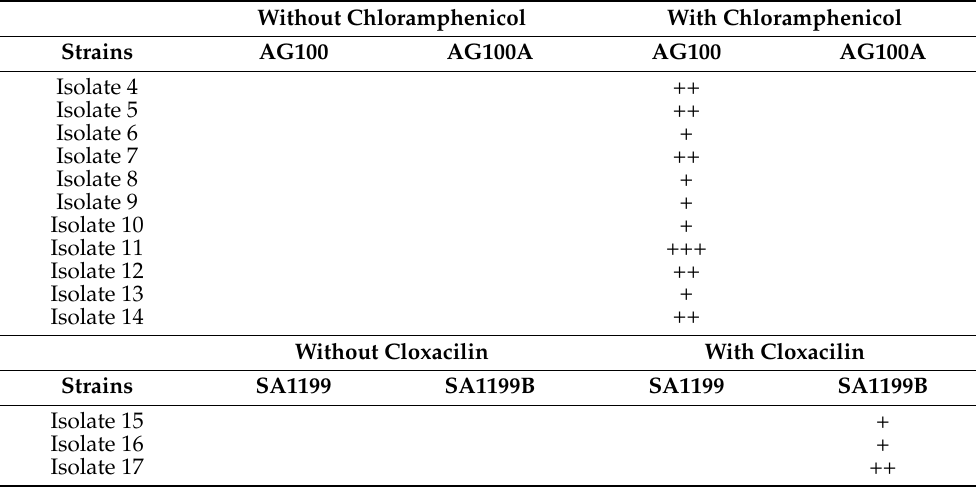
Table 2. The Actinobacteria isolates showing an efflux pumps inhibitory activity against E. coli in the absence and presence of the antibiotic.